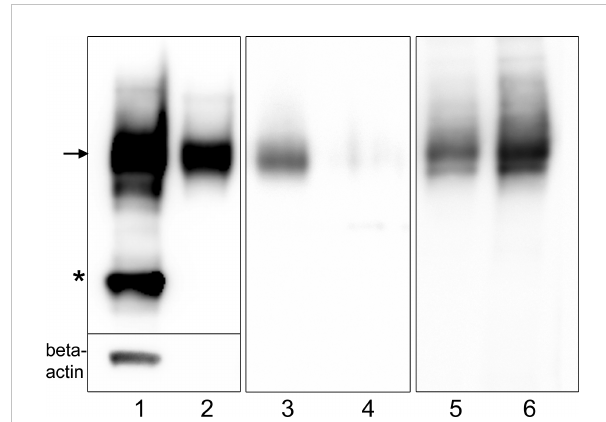
FIGURE 1 Immunoblots showing that IgLON5 is spontaneously shed and cleaved at the GPI-anchor. Immunoblots of different protein preparations from IgLON5-HEK probed with IgLON5 and actin antibodies: cell lysate (1); media obtained from 10 P60 plates with IgLON5-HEK cells (2); membrane preparations from one P60 plate untreated (3) and treated with PI-PLC (4); media from one P60 plate untreated (5) or treated with PI-PLC (6). Arrow indicates the glycosylated band of IgLON5 of approximately 60 kDa and the asterisk points the 37 kDa unglycosylated band. Only the lysate lane shows a beta-actin band, ruling out that the IgLON5 band detected in the other lanes is derived from dead IgLON5-HEK